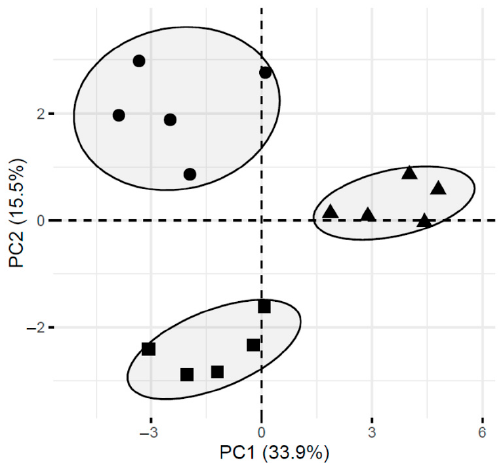
Figure 2. Canned tuna samples covered with EVOO with different green ‐ fruity intensities: ● greenly light fruity sensation ; ■ greenly intense fruity sensation; and, ▲ ripely fruity sensation. PCA plot based on the sensory profiles and intensities assessed by trained panelists (visual, olfactory, kinesthetic, and gustatory attributes).